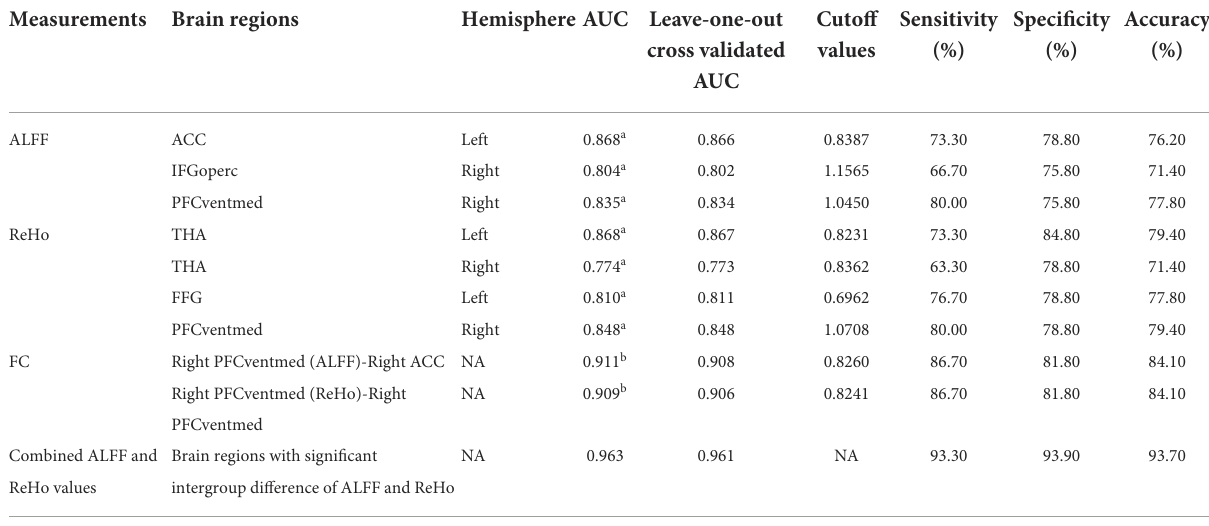
TABLE 4 Classification performance of neuroimaging indices in discriminating between BMP patients and healthy controls. Measurements Brain